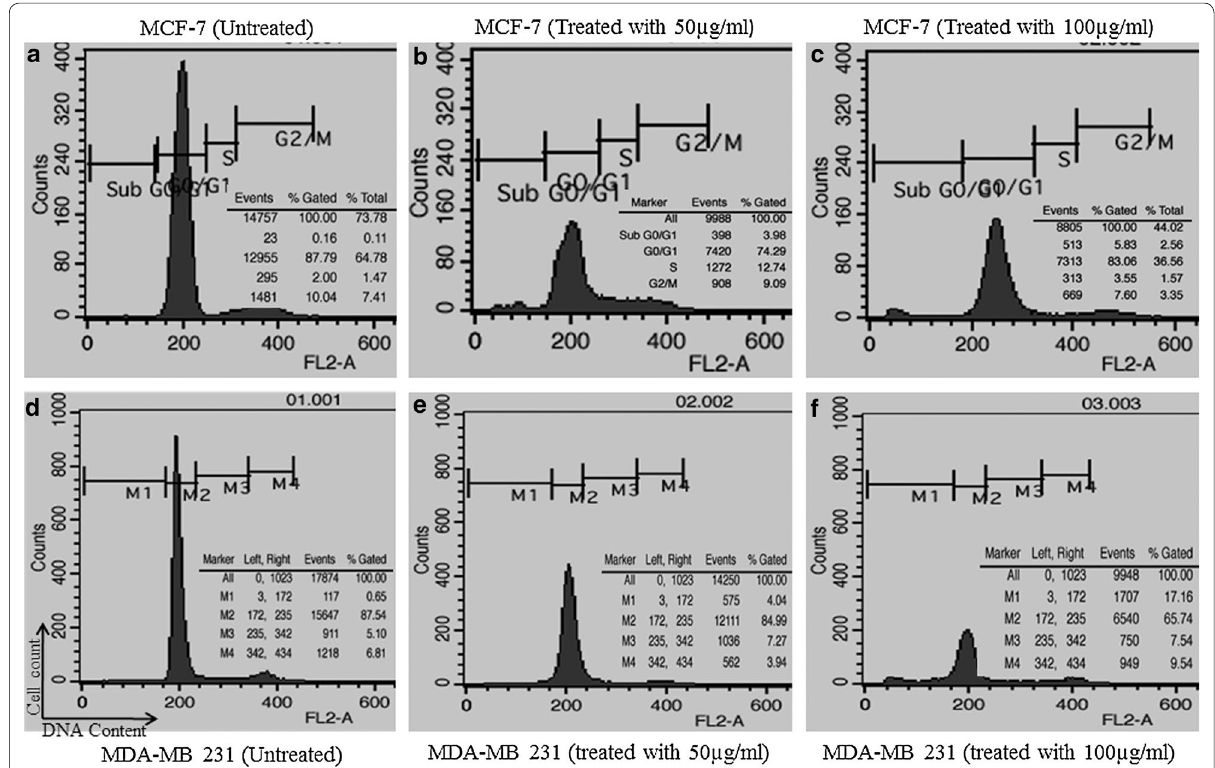
Fig. 3 Representative histograms depicting cell cycle distribution in MDA-MB-231 and MCF-7 cultures following 48 h treatment with 50 and 100 µg/ml concentrations of BTB extract caused S and G2/M phase cell cycle arrest in MCF-7cells ( b , c ) and MDA-MB231 cells ( e , f ) with comparison to untreated control cells ( a , d